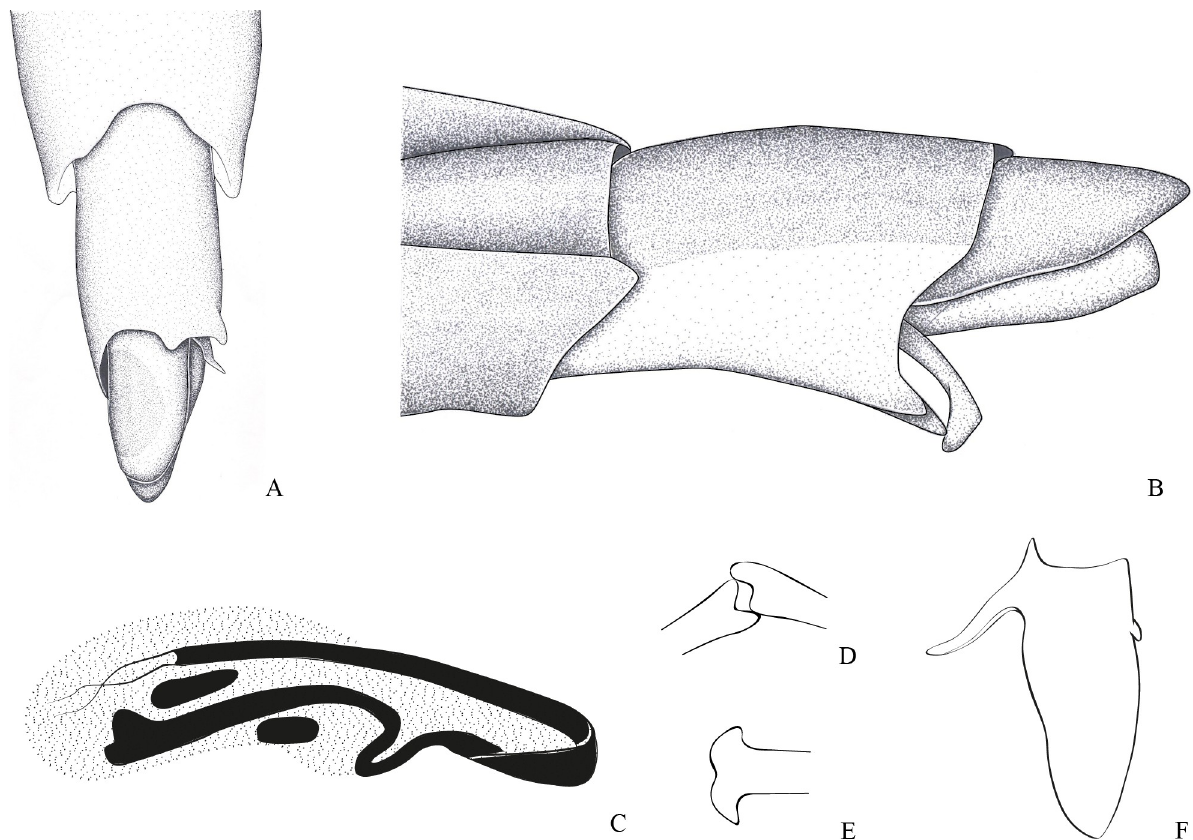
Fig 2. Potamobates bidentatus . (A) Male, terminalia, ventral view; (B) male, terminalia, vista left lateral view; (C) Phallus, lateral view; (D) junction between dorsal and ventral sclerite; (E) ventral sclerite base; (F) proctiger, dorsal view. Redescription. Body length 3.3–4.8 times larger than width through mesoacetabula. Head : width through eyes 1.0–1.6 times larger than head length. Eye reniform, greatest width 1.3–2.0 times larger than minimum interocular distance. Mandibular and maxillary plates fused (Fig 5B). Clypeus rounded anteriorly (Fig 5A); epistomal suture absent (Fig 5C). Anten- niferous tubercle protuberant. Antenna short, subequal in length to fore leg; antennomere I 2.3–3.1 times longer than II, 0.7 times of length of II + III; II from subequal in length to 1.7 times longer than III; IV subequal to 1.5 times longer than III. Labium short, reaching at most anterior portion of mesosternum (Fig 5B); articles I and II short; III 1.5–2.3 times longer than IV (Fig 5B). Thorax : pronotum with a median stripe (Figs 13A, 13D, 14A and 14C) or wedge- shaped mark (Figs 15A, 15C, 16A and 16C); propleuron with an anterior patch of golden setae (except in P . horvathi ); proacetabulum with a patch or wide stripe of golden setae (Fig 17A and 17B). Fore femur subequal in length to fore tibia, proximal region with denticles; fore tar- somere II 2.2–5.0 times longer than I. Mesonotum with median length subequal to width through mesoacetabula, uniformly black or with yellowish longitudinal stripe(s); mesopleuron with a continuous or interrupted stripe of golden setae. Middle femur with 0.9–1.0 of length of hind femur, 1.4–1.7 times longer than middle tibia; middle tarsomere I 3.0–6.0 times longer than II; middle pretarsal claws absent. Metanotum uniformly black or with a median yellowish stripe, width through acetabula 2.5–3.5 times median length; metapleuron with a patch or lon- gitudinal stripe of golden setae. Hind femur 1.6–2.1 times longer than hind tibia; hind